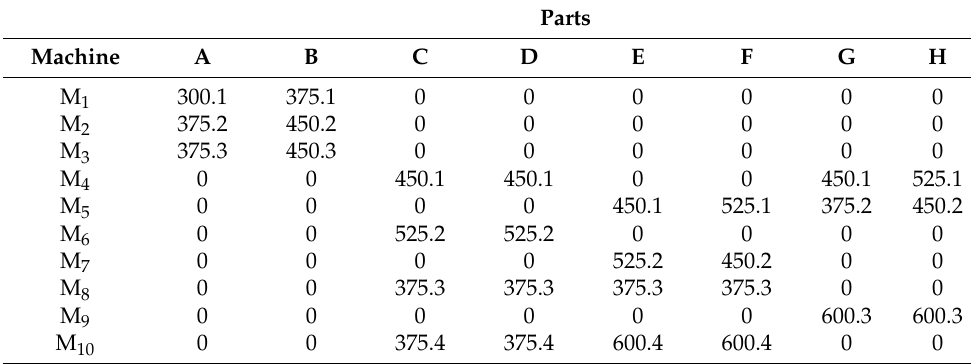
Table 2. Parts-processing time and process sequence.